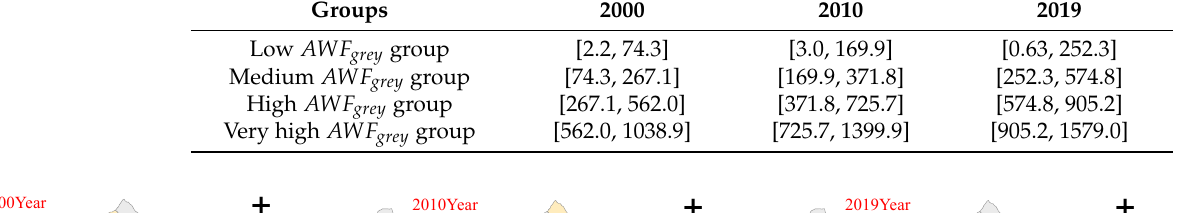
Table 2. Threshold ranges of AWF grey in low, medium, high and very high groups (10 6 m 3 ). Groups